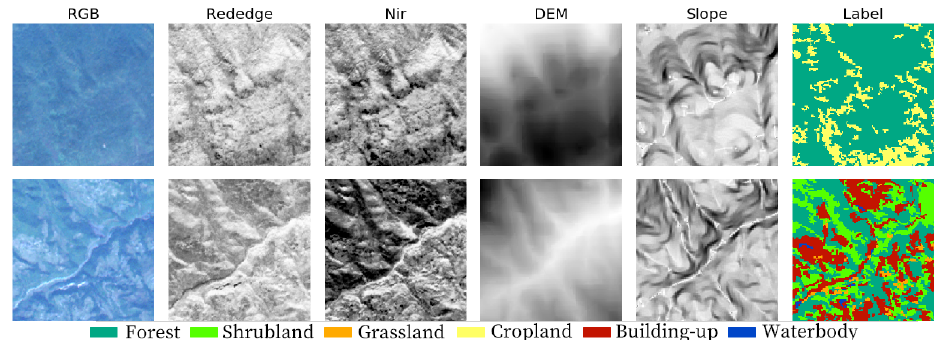
Figure 6. Image patches with ground truth label using sliding window. The RGB, red edge, and near infrared band were from RapidEye imagery. The DEM and slope represent topographic